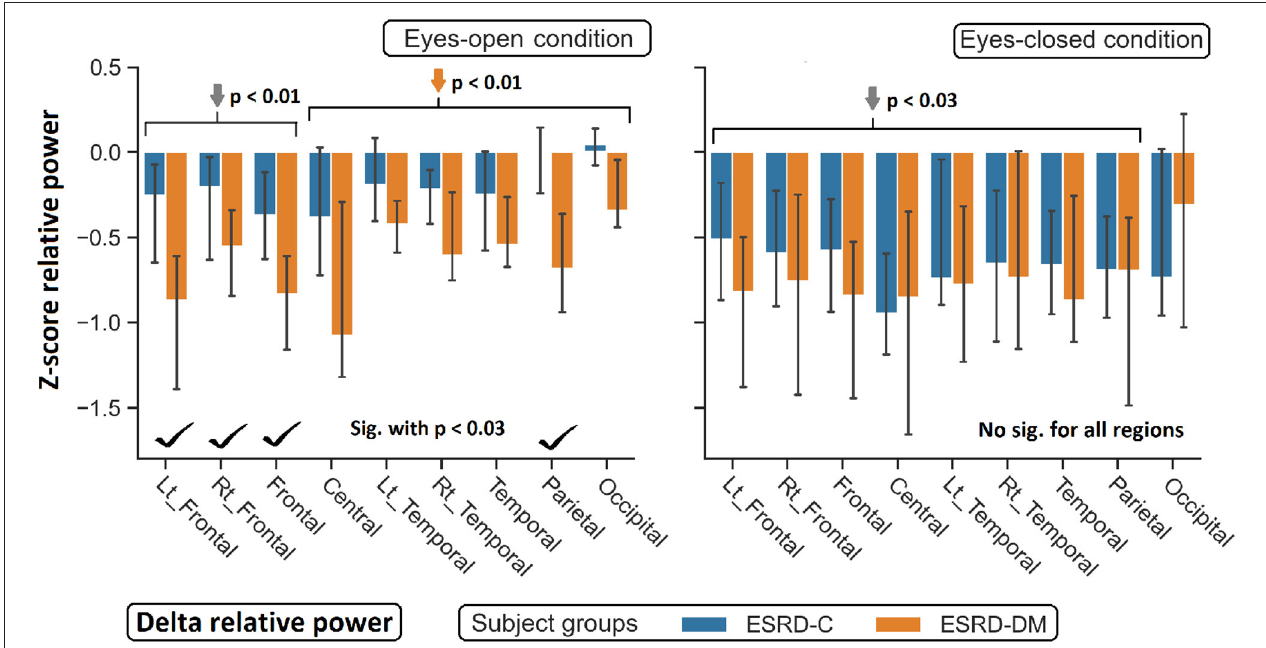
FIGURE 4 | Z-scores of delta relative power in nine topographical regions are demonstrated. The significant difference between eyes-open ESRD-C and ESRD-DM was appeared in frontoparietal regions as signified by check mark. Comparing to healthy control, delta values of ESRD-DM was found lower throughout most regions (orange arrows). P -values were calculated by Mann–Whitney U -test. The whisker indicates 95 percent confident intervals with median as an estimator. Gray arrows refer to deviation from healthy control in both subject groups.